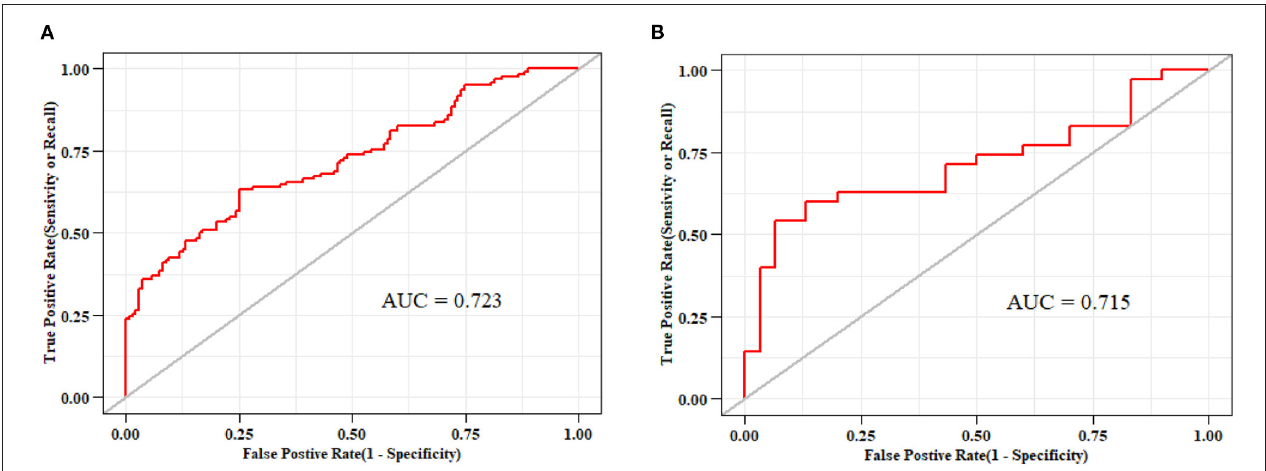
Frontiers in Nutrition |